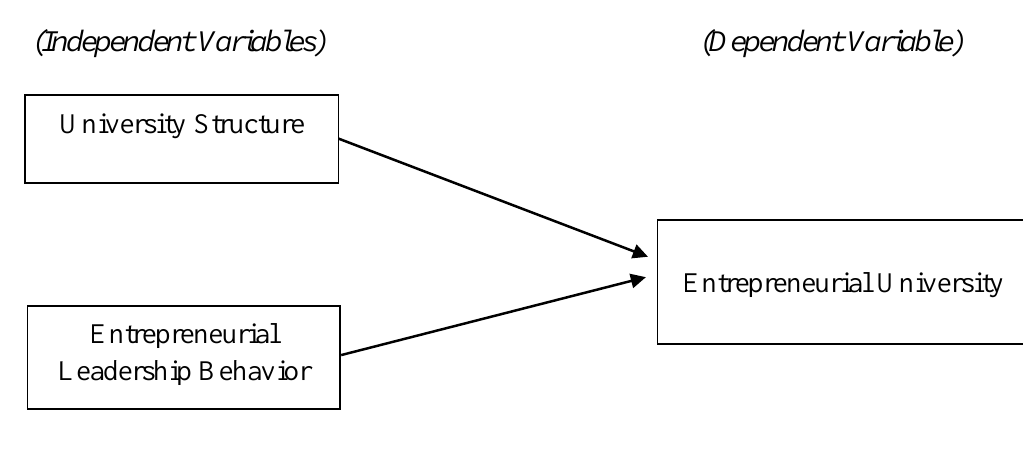
Figure 01: Conceptual Framework of the